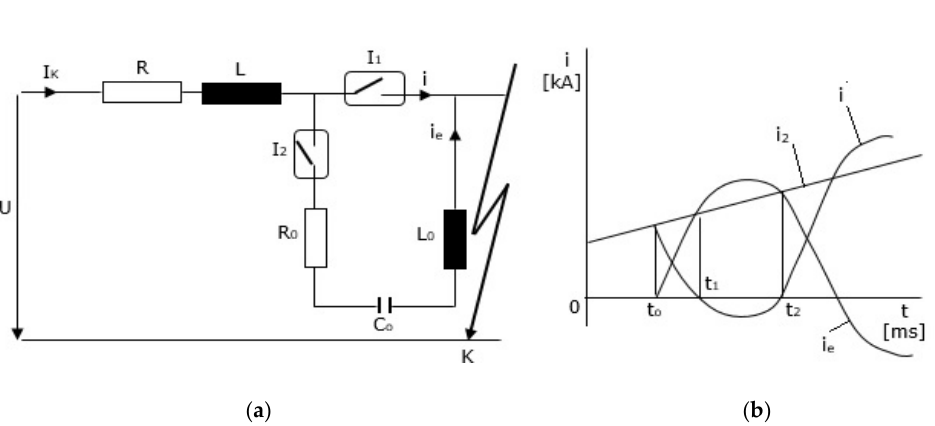
Figure 3. Modelling of the electric arc: ( a ) electric scheme of the circuit; ( b ) current variation [1].